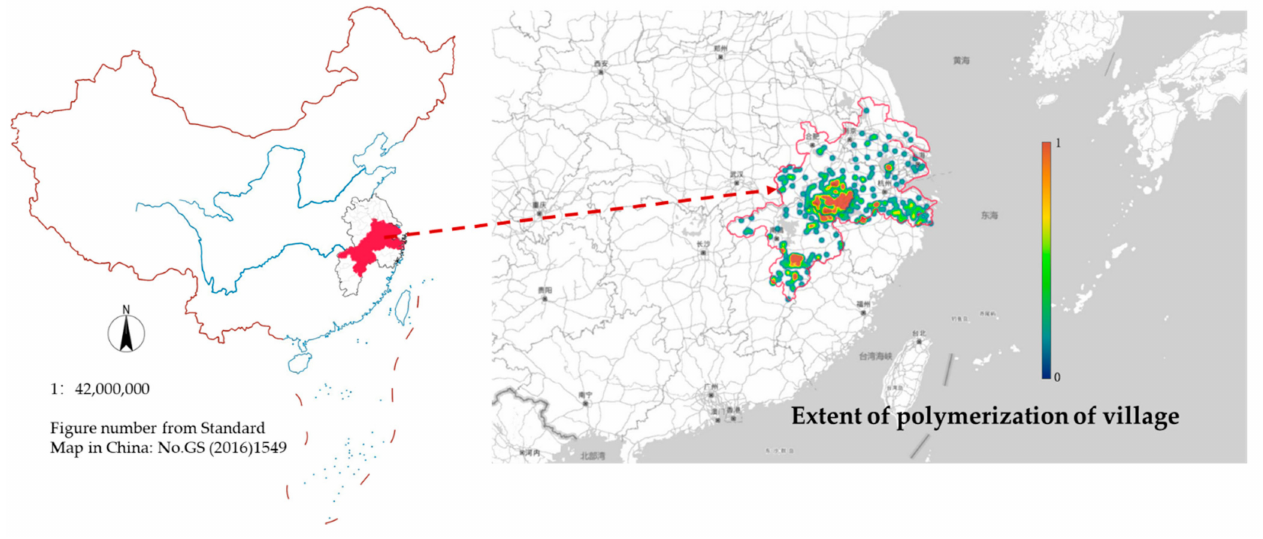
Figure 1. Jiangnan region of China: edited by authors. Table 1. Urban regeneration typical sample of traditional villages in Jiangnan region: edited by authors, information is obtained from field research, photographs taken by